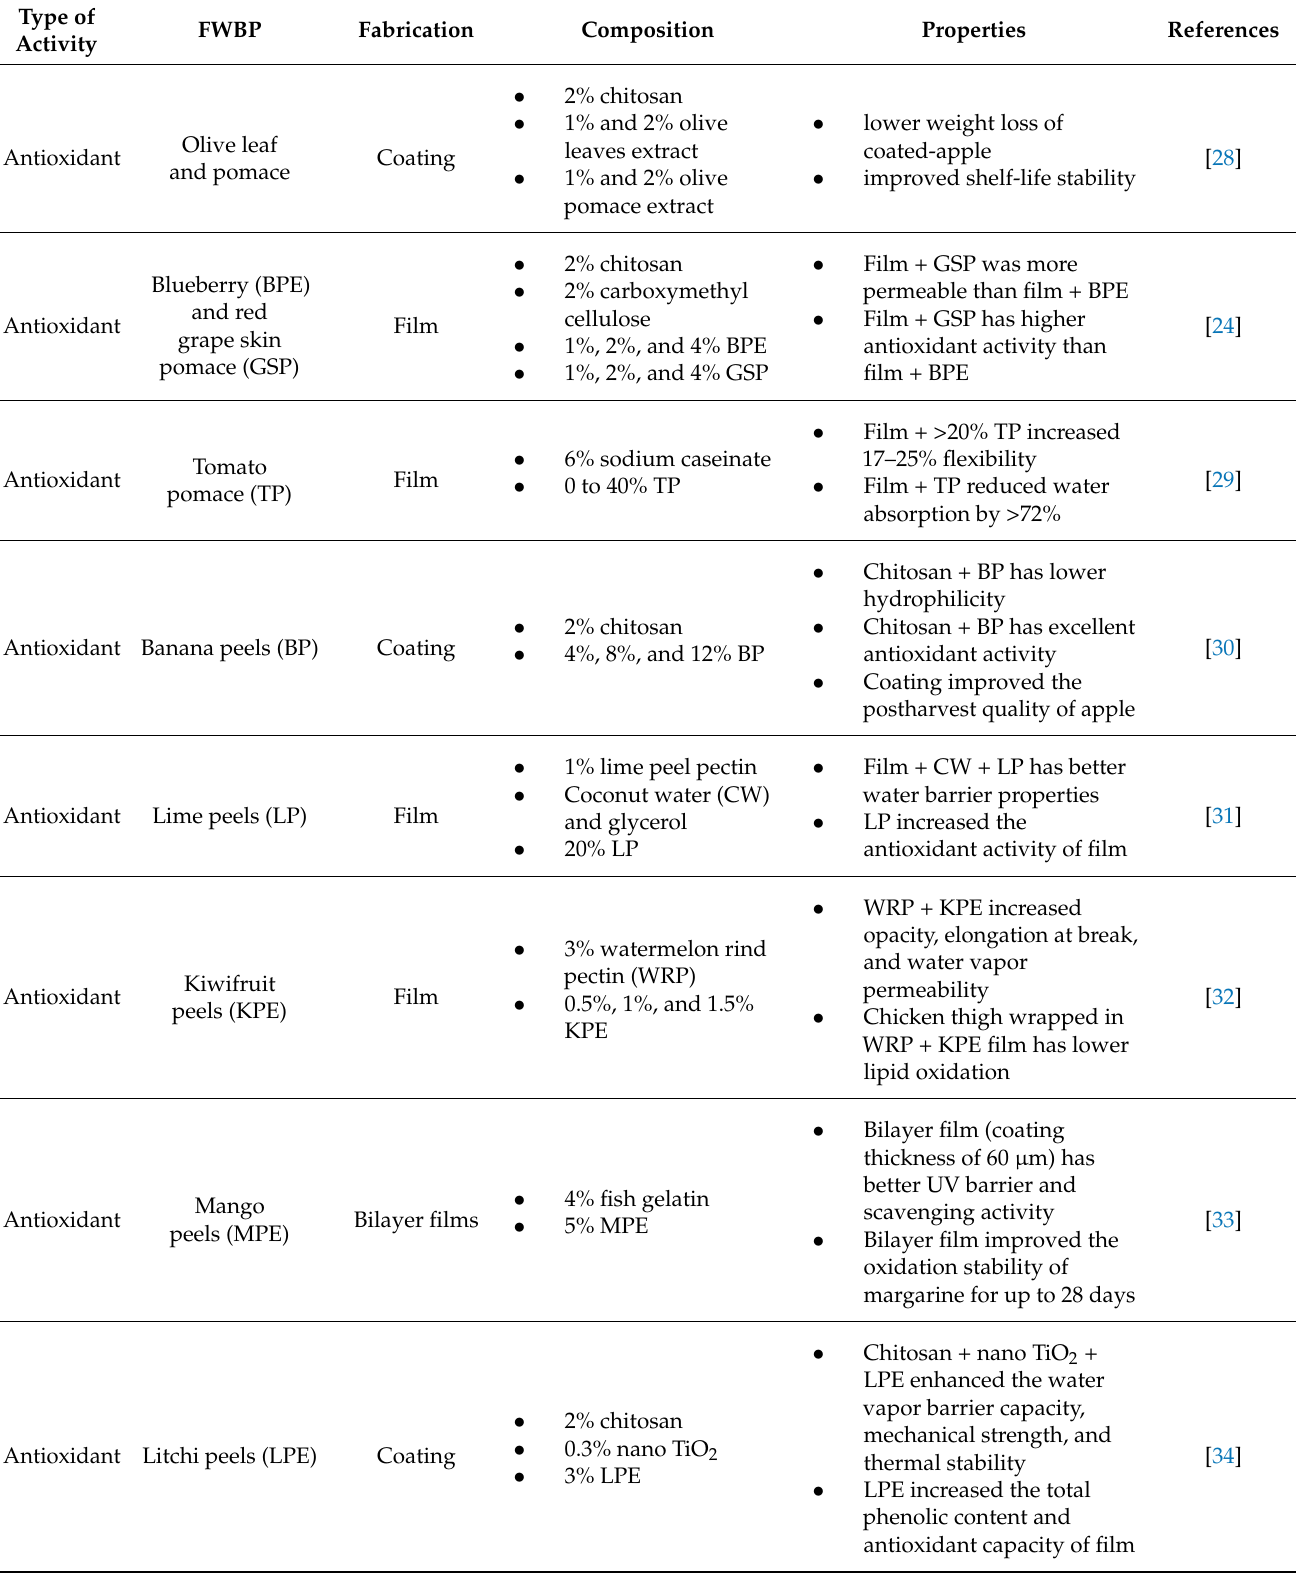
Table 2. Utilization of food waste and by-products as antioxidants and antimicrobial